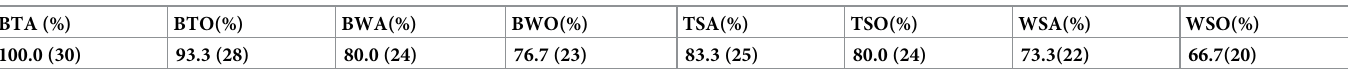
Table 2. Qualified staining section success rate.